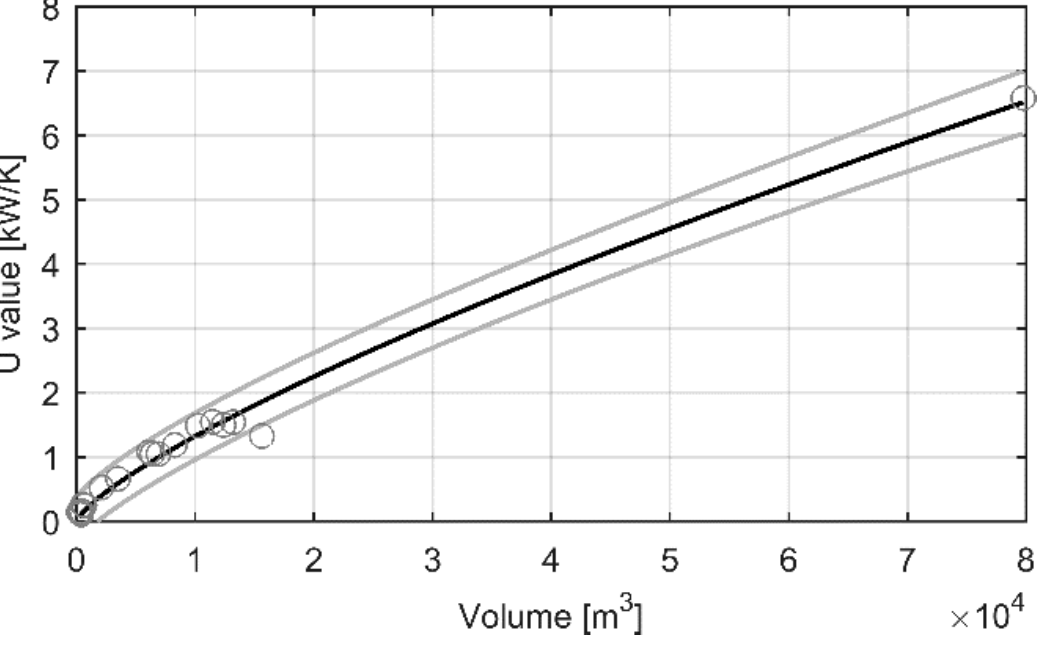
Figure 1. Plot for volume vs. U value. Circles are the calculated U values, black line is the power function U = 0.001119 × V 0.7681 and grey lines are the 95% confidence bounds.